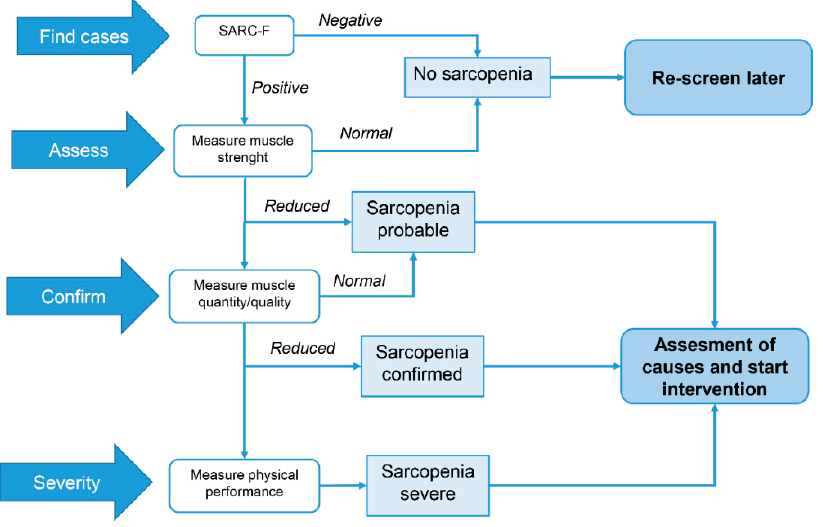
Figure 1. EWGSOP-2 algorithm for the diagnosis of sarcopenia. Find the case, make the diagnosis, and quantify the severity.